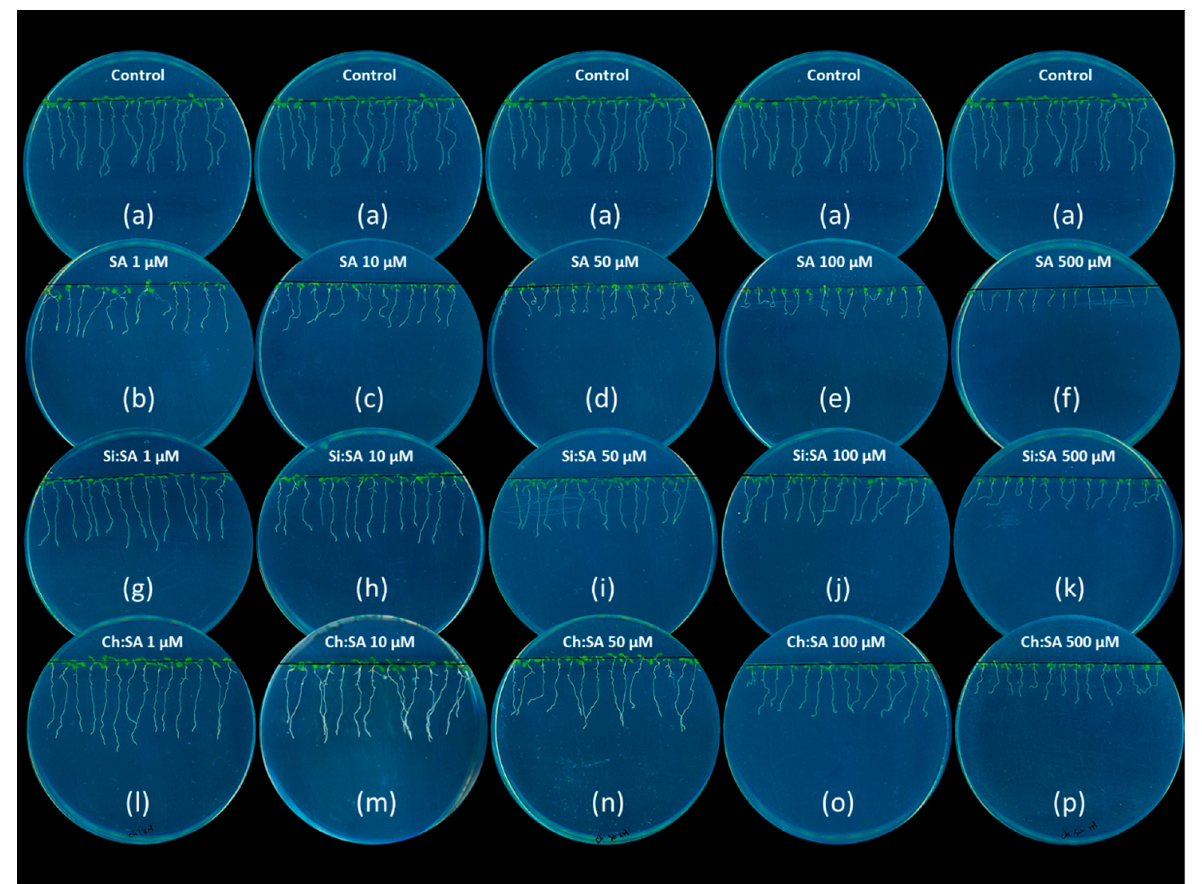
Figure 2. Effect of free SA, Si:SA and Ch:SA on root growth in Col-0 Arabidopsis plants. Five-day-old plants were transferred to media containing the different SA treatments and pictures were taken 5 days later.